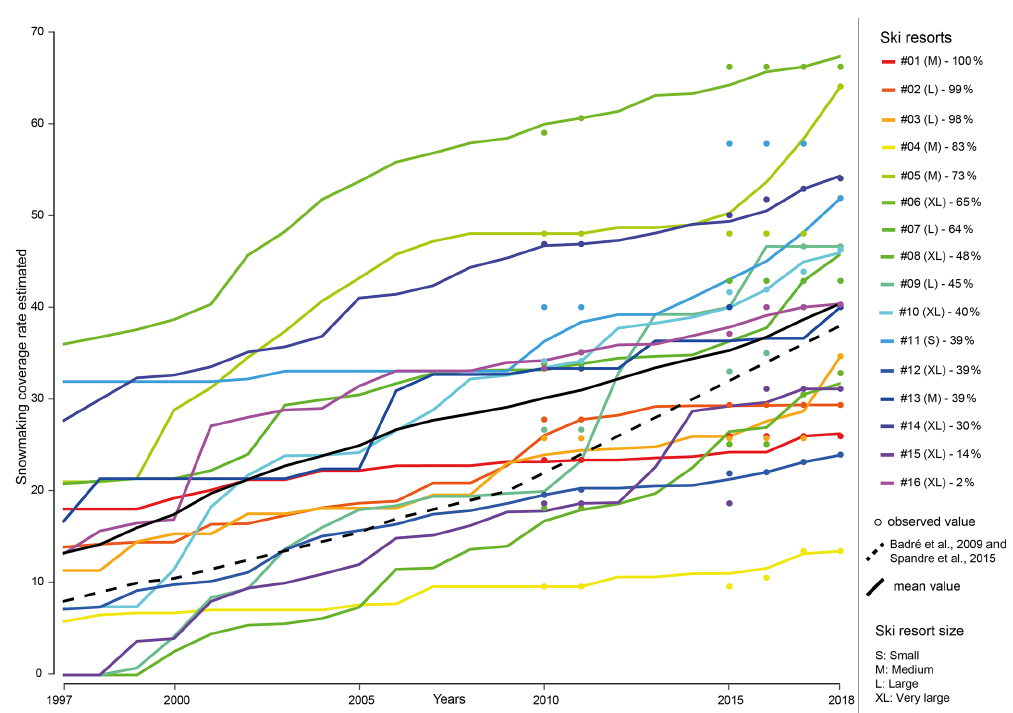
Figure 2. Evolution of the snowmaking coverage rate over 1997–2018 for the 16 ski resorts in Savoie with the linear model. Colours represent individual ski resorts, anonymized and ordered as a function of the decreasing fraction of the domain below 2000m.